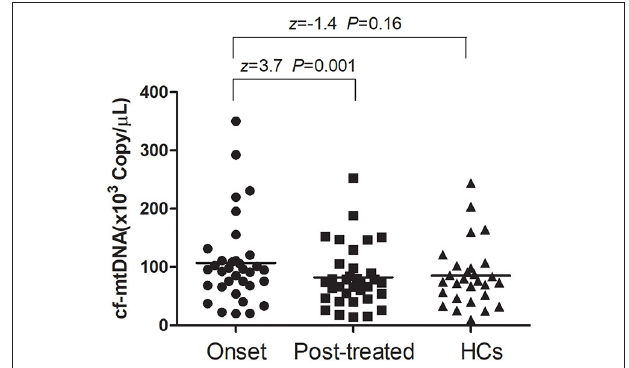
FIGURE 1 | Comparison of the plasma cell-free mitochondrial DNA (cf-mtDNA) levels among the different groups. The Wilcoxon Mann–Whitney test was used for the data analysis between the onset and healthy controls (HCs) groups ( z = − 1.4, P = 0.16). The Wilcoxon signed-rank test was used for the data analysis between the onset and posttreated groups ( z = 3.7, P =